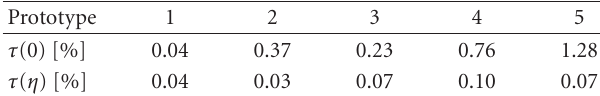
Table 4: Relative mean error between the modeled and measured resonance frequencies of the bent prototypes for the TM 01